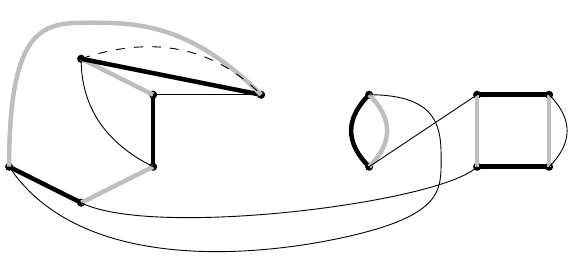
Figure 5 . The graph G 0 = A 0 [ B 0 with P 0 .